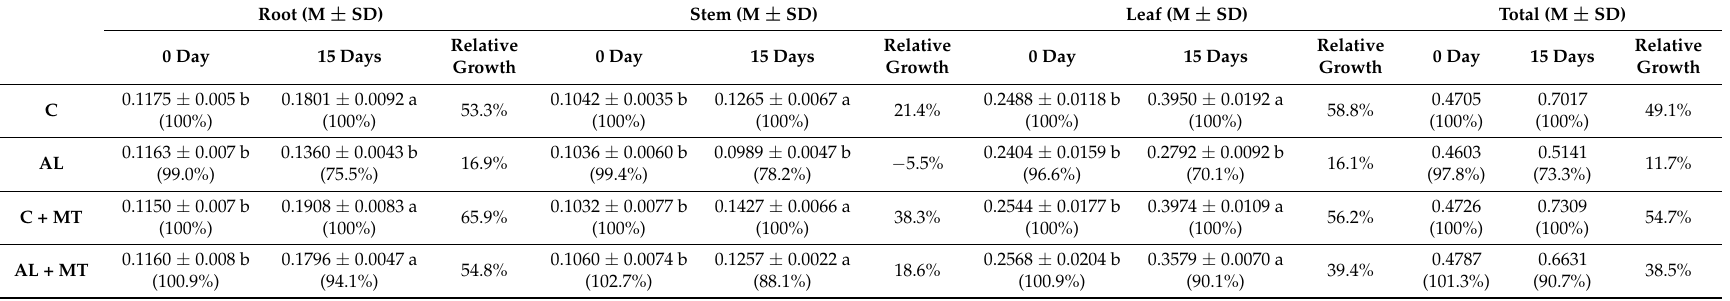
Table 3. Effects of 5 µ M melatonin treatment on tissue dry weights (DW, g) measured from Malus hupehensis Rehd. seedlings under alkaline